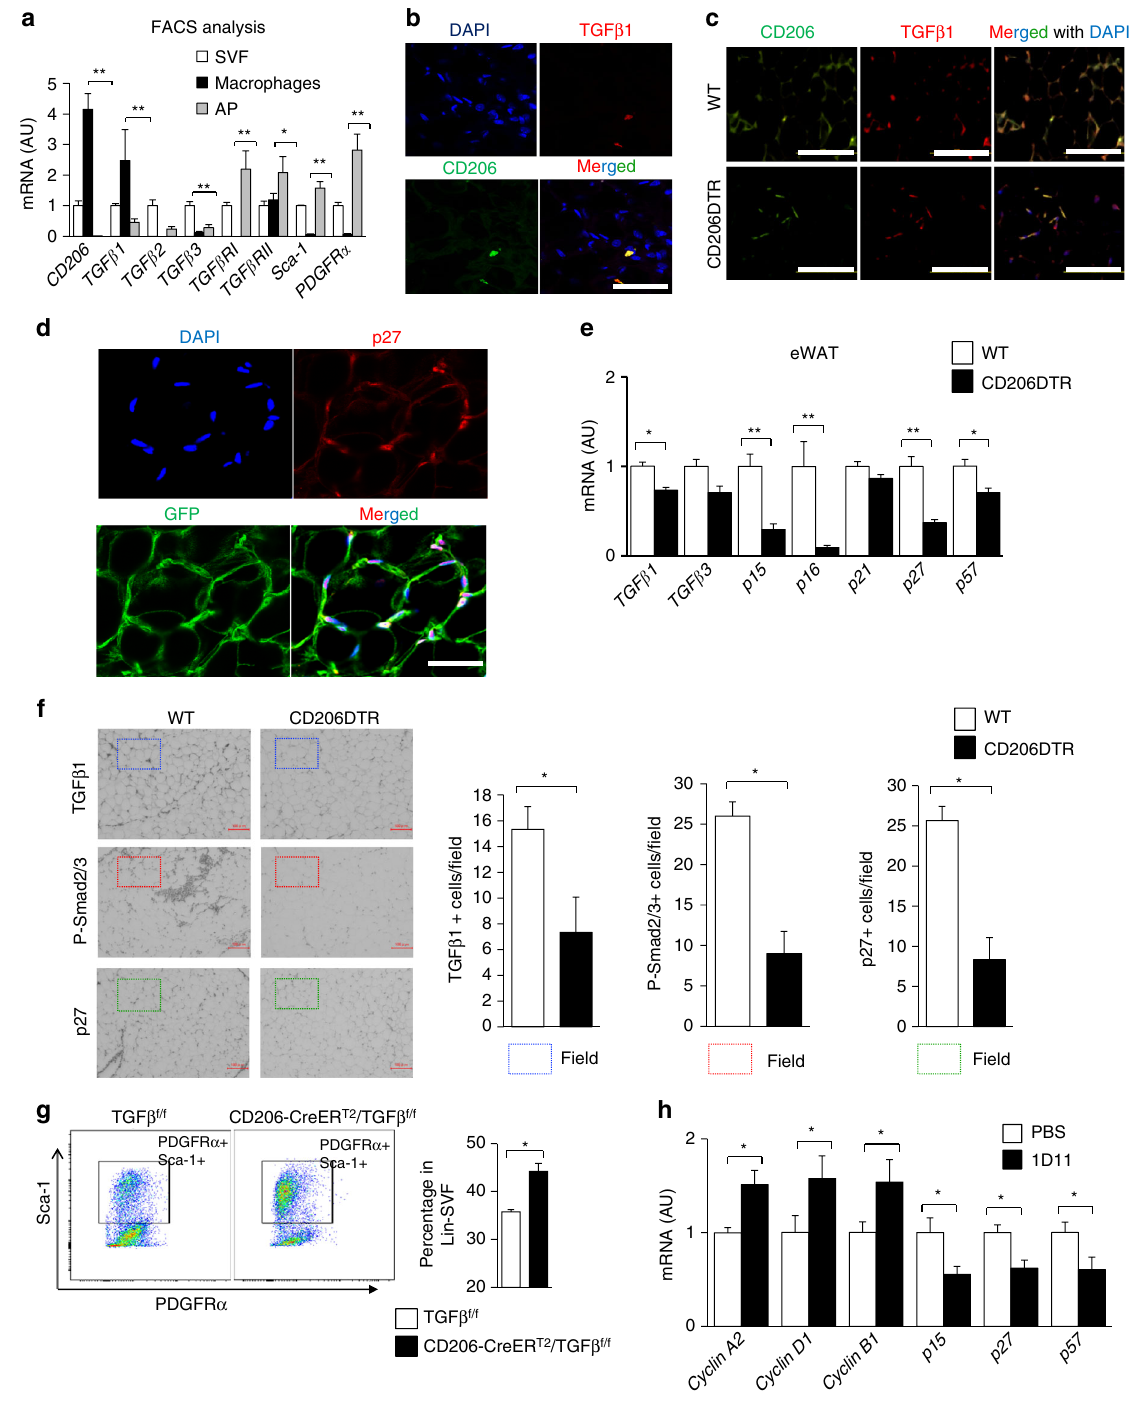
Fig. 4 TGF β signaling is reduced after CD206 + M2-like macrophages depletion. a Relative mRNA expression of CD206, TGF β 1, TGF β RI , and TGF β RII , in the SVF, macrophages (CD206 + ), and APs puri fi ed from eWAT of WT mice by using FACS ( n = 4 – 5 per group). b High resolution confocal imaging of frozen eWAT sections from WT mice. Scale bar , 25 μ m. c Representative images of eWAT paraf fi n sections stained for CD206 and TGF β 1 ( Scale bar , 200 μ m) in DT-treated CD206DTR and WT littemate. d High resolution confocal imaging of frozen eWAT sections from WT mice stained for GFP vs. p27. The images were taken with a Leica TCS-SP5 (Oil 63×). Scale bar , 25 μ m. e Relative expression of TGF β signaling genes in eWAT. f Representative immunohistochemical staining of the eWAT paraf fi n section for TGF β 1, phospho-smad2/3 (P-Smad2/3), and p27. Scale bar 100 μ m. Quanti fi cation ( right panel ) ( n = 3 – 4 per group). g Representative fl ow cytometry analysis of Sca-1/PDGFR α double positive population in the SVF of eWAT from CD206-CreER T2 /TGF β fl ox/ fl ox and TGF β fl ox/ fl ox control mice. Percentage of Sca-1/PDGFR α double positive fraction was calculated ( right panel ; n = 4 – 5 per group). Full gating strategy is given in Supplementary Fig. 7d. h The relative mRNA expression of cell cycle and TGF β signaling genes from eWAT samples collected after direct injection of a single dose of TGF β neutralizing antibody (1D11) into the eWAT ( n = 3). The data are shown as the means ± SEM. * P < 0.05, ** P < 0.01 compared with littermates by Student ’ s t